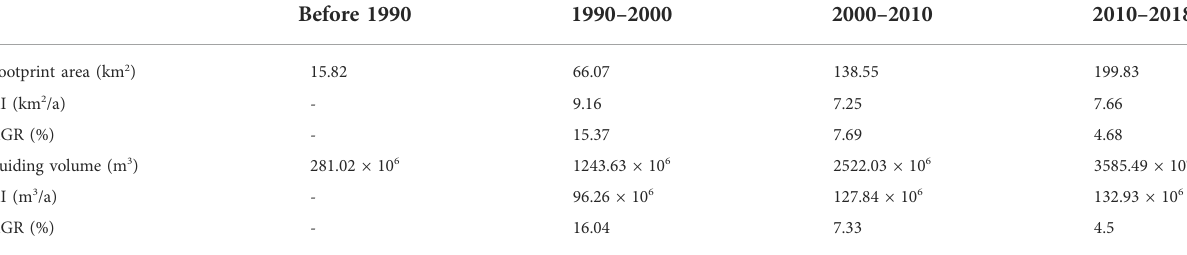
TABLE 3 Growth speed and morphological characteristics of Shenzhen during 1990 – 2018. AI, Annual increase; AGR, normalized annual growth rate